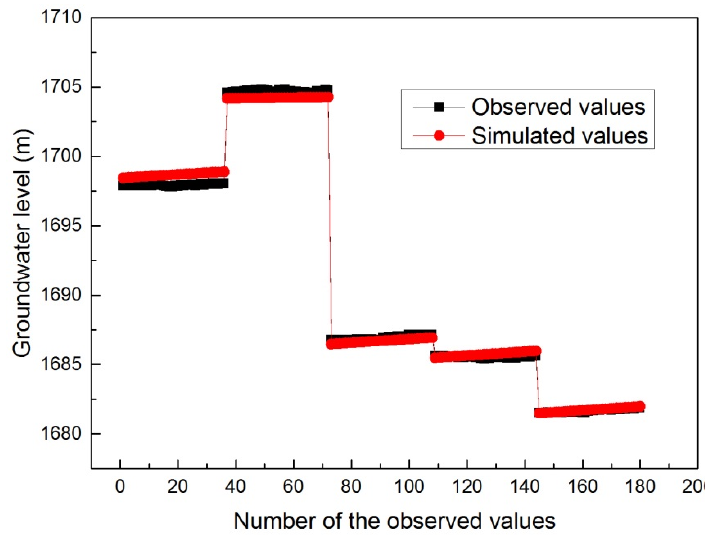
Figure 9. Observations and fitting values of the groundwater level in the model validation period.